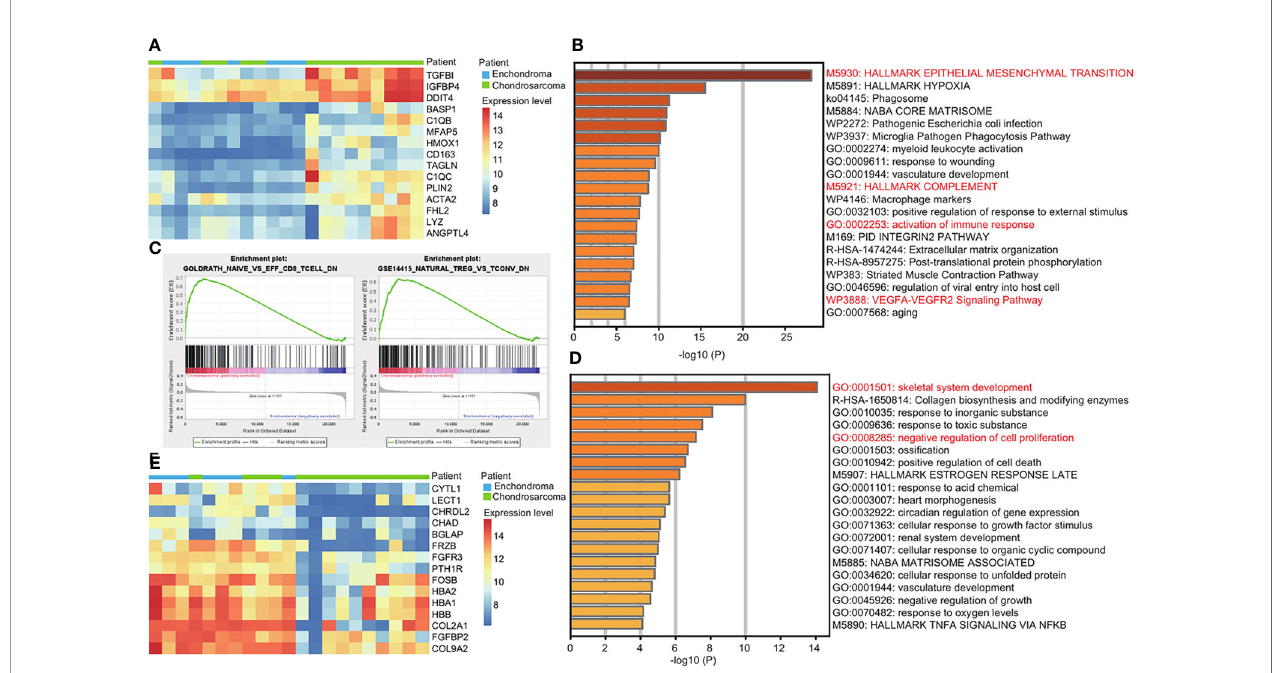
FIGURE 2 | Immune response is more active in CS compared with EC. (A) Heatmap of the top 15 upregulated genes in CS compared with EC. Red and blue represent high and low expression levels, respectively. (B) Metascape enrichment analysis of the top 100 upregulated genes in CS. The color shows the p value. (C) GSEA map of immunologic signature gene sets in EC and CS. (D) Metascape enrichment analysis of the top 100 downregulated genes in CS. The color shows the p value. (E) Heatmap of the top 15 downregulated genes in CS compared with EC. Red and blue represent high and low expression levels,